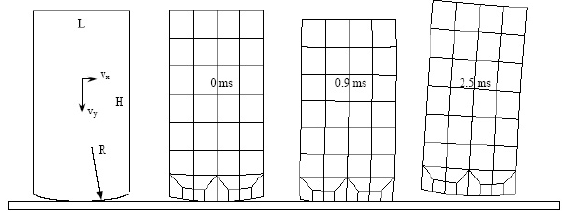
Fig. 2. Oblique impact of an elastic plate: geometry and de- formed shapes vs time. Table 1. Comparison of CPU